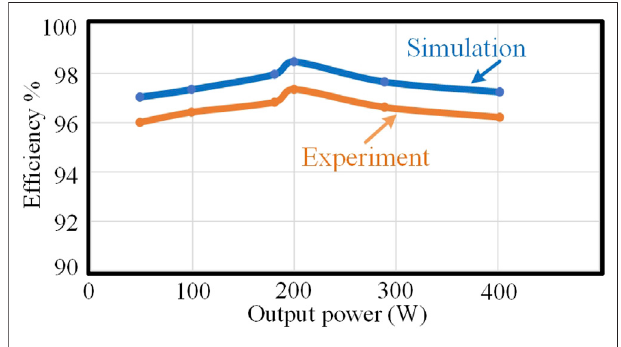
FIGURE 4 | Ef fi ciency curve.